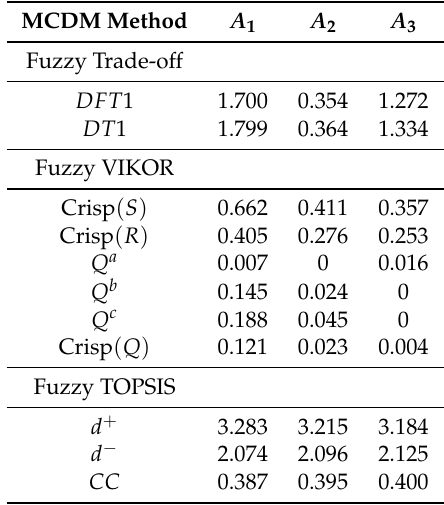
Table 15. Results by the fuzzy MCDM methods with the new criteria